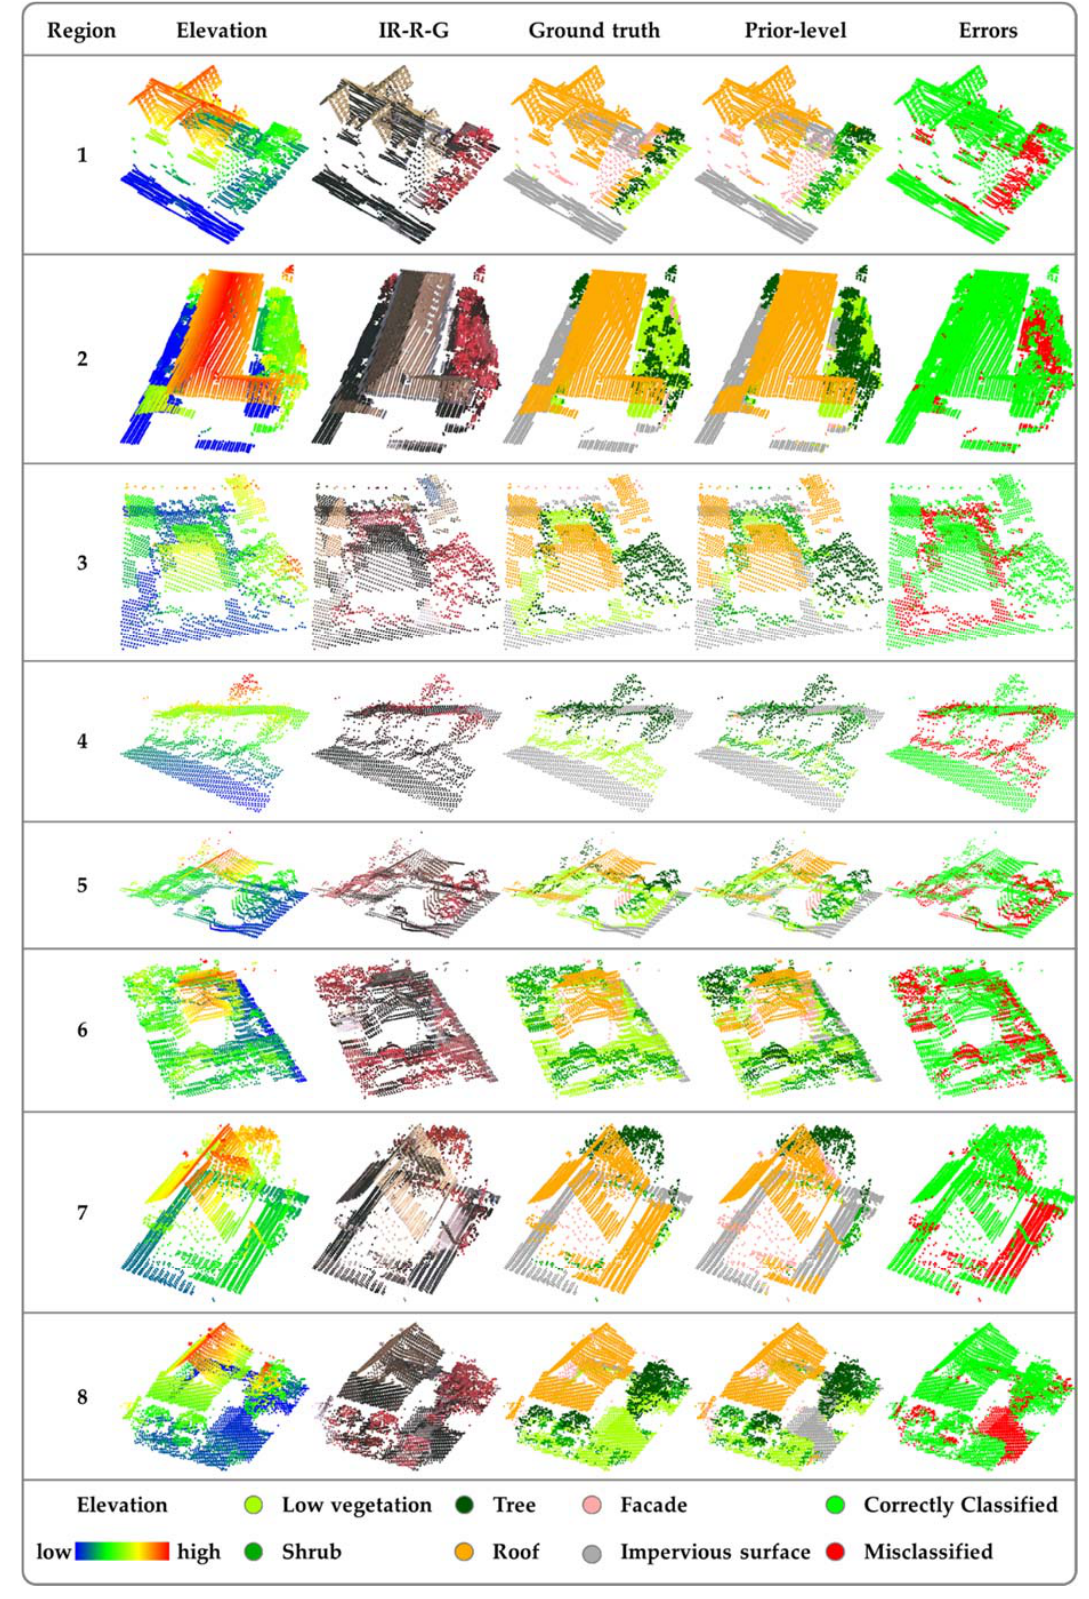
Figure 10. Selected regions from error maps of the prior-level fusion strategy.